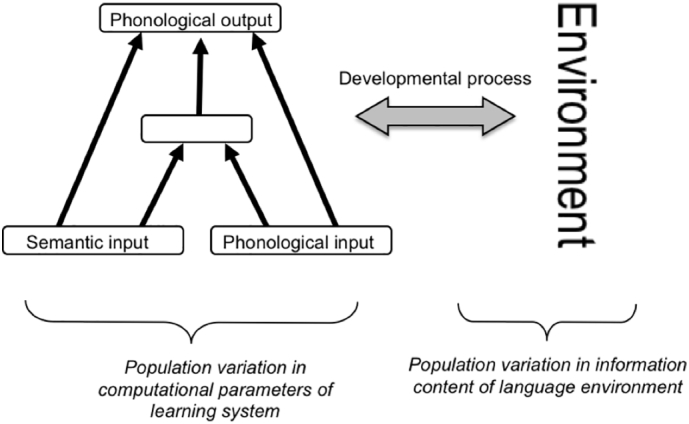
Schematic of the population simulations (from Thomas et al., 2013).